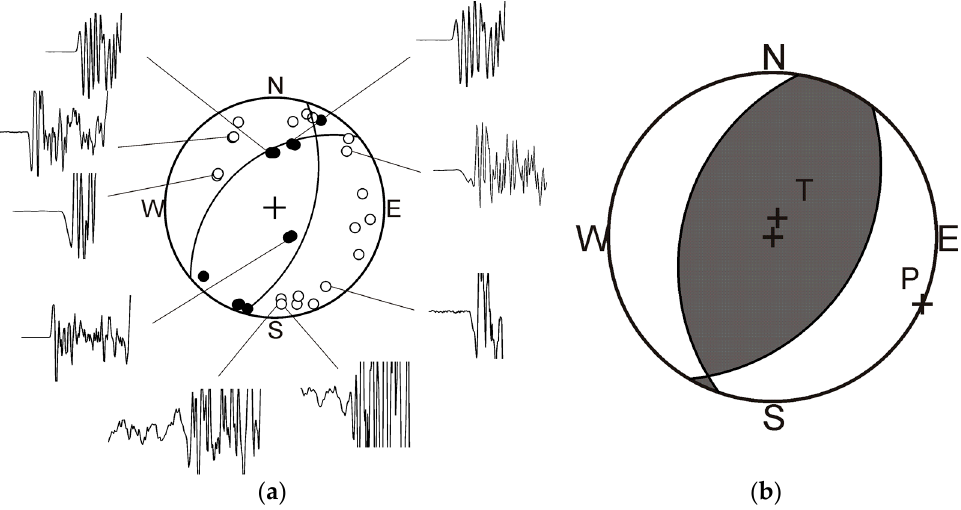
Figure 7. ( a ) Waveforms of eight M > 3 earthquakes after the Tohoku earthquake and fault plane solution for the largest event (M 3.4, 3 June 2011). Open circle and closed circle represent negative and positive P-wave polarities, respectively; ( b ) Fault plane solution for the 1998 M 5.0 earthquake on the Nagamachi-Rifu fault, which was reproduced following the result by Umino et al. [14].